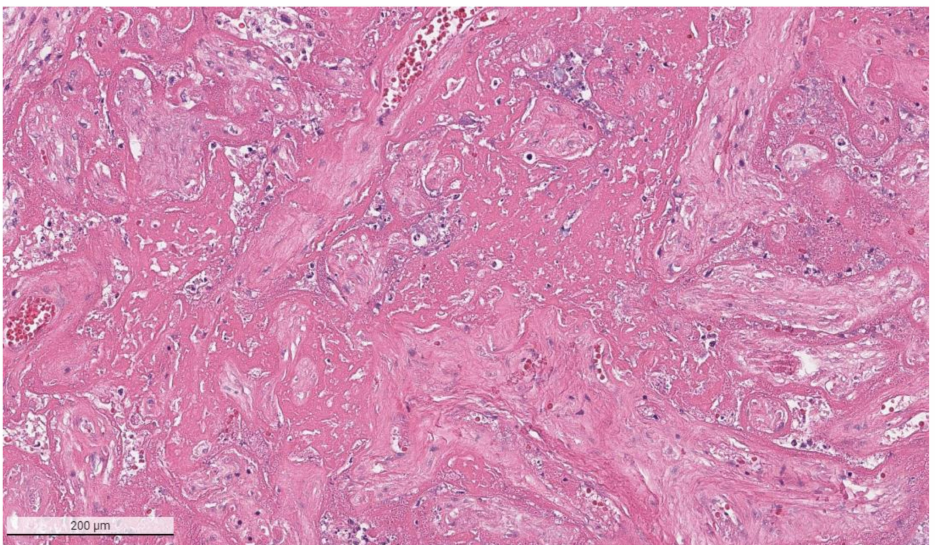
Figure 3. Higher magnification of a placenta with SARS-CoV-2 infection and SARS-CoV-2 placentitis. There is massive perivillous fibrin deposition with ischemic necrosis of the chorionic villi and villous trophoblast. There is complete obstruction of the intervillous space with fibrin which prevents maternal blood flow though this region of the placenta. Hematoxylin & eosin staining, × 10.